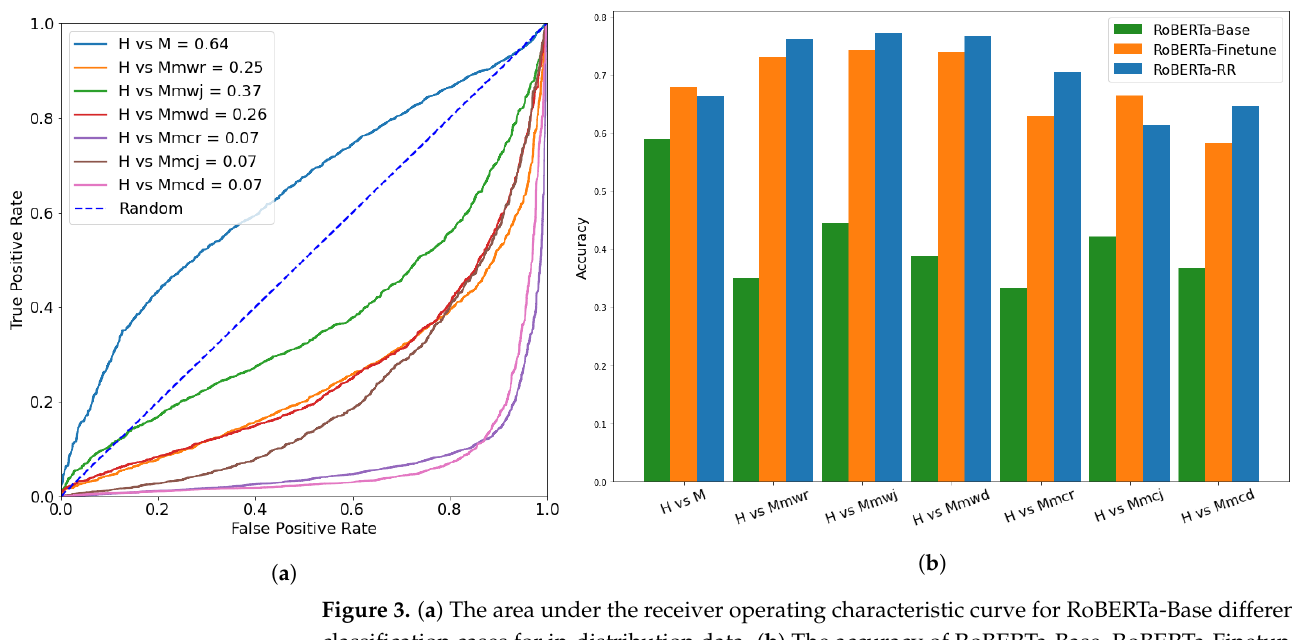
Figure 3. ( a ) The area under the receiver operating characteristic curve for RoBERTa-Base different classification cases for in-distribution data. ( b ) The accuracy of RoBERTa-Base, RoBERTa-Finetune, and RoBERTa-RR in different cases. The absolute accuracy values of each bar are reported in Tables 1 and 2.